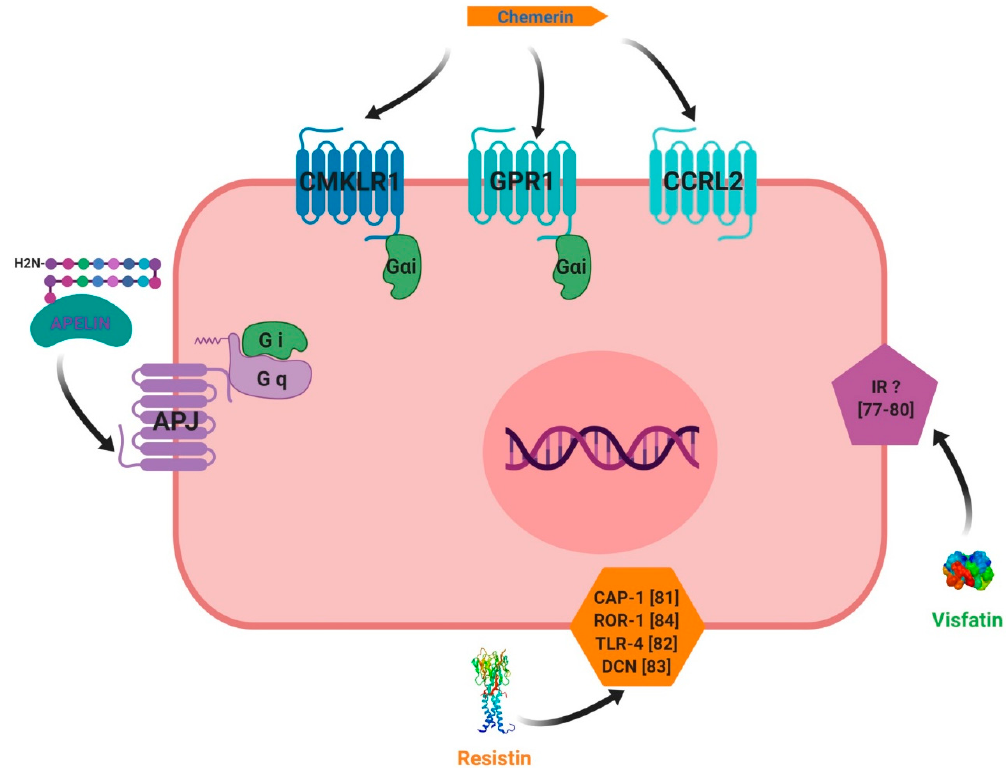
Figure 5. Receptors used by chemerin, visfatin, resistin and apelin for their signaling pathways. chemerin can bind three different receptors that are CMKLR1, GPR1 and CCRL2. CMKLR1 and GPR1 are coupled with intracellular G α i proteins. The last receptor doesn’t have any active signaling pathway identified until now suggesting a putative role of co-receptor for CCRL2. Apelin has its own receptor called APJ coupled with intracellular Gq and G α i proteins. Resistin could bind receptors such as CAP-1, ROR-1 and TLR-4 but it has to be confirmed. No receptor for visfatin has been identified until